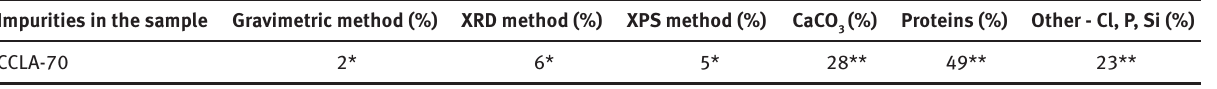
Table 3: Total impurities present in isolated chitin sample and the impurity composition in chitin. Complete XPS elemental analysis is available in (Table